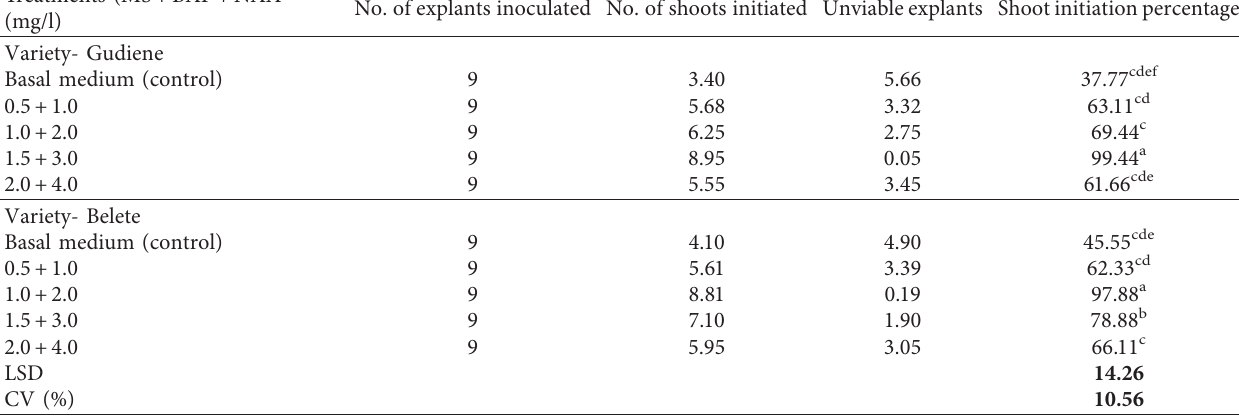
Table 1: The effect of BAP and NAA on shoot initiation in Gudiene and Belete varieties of potato. Treatments (MS+BAP+NAA